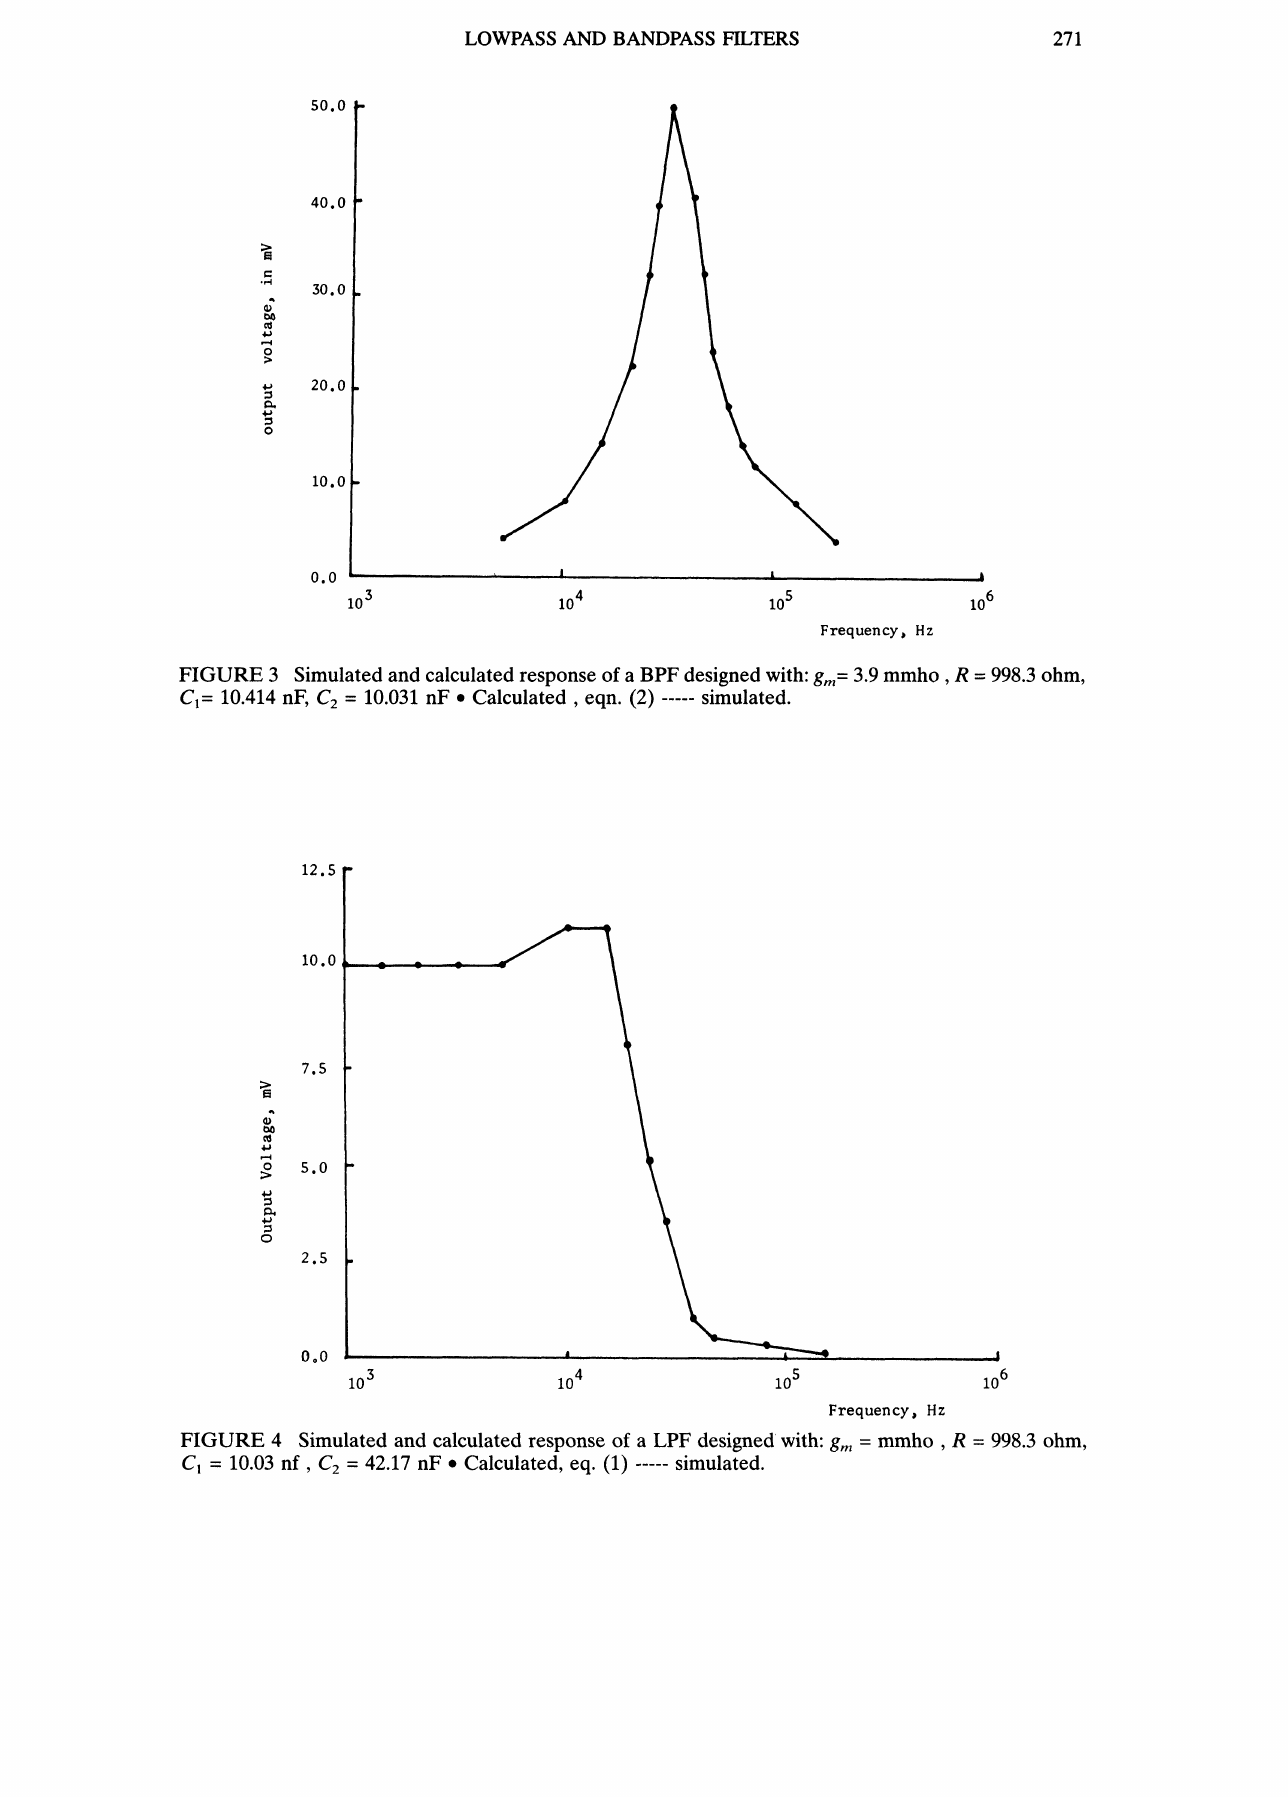
FIGURE 4 Simulated and calculated response of a LPF designed with: